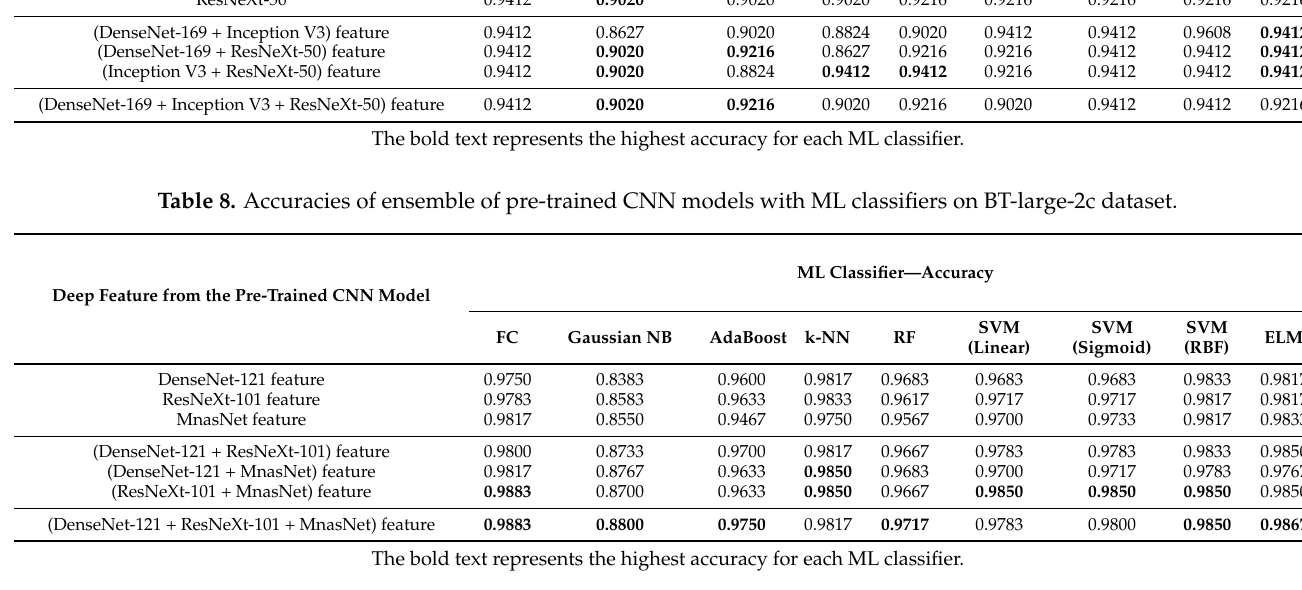
Table 9. Accuracies of ensemble of pre-trained CNN models with ML classifiers on BT-large-4c dataset.